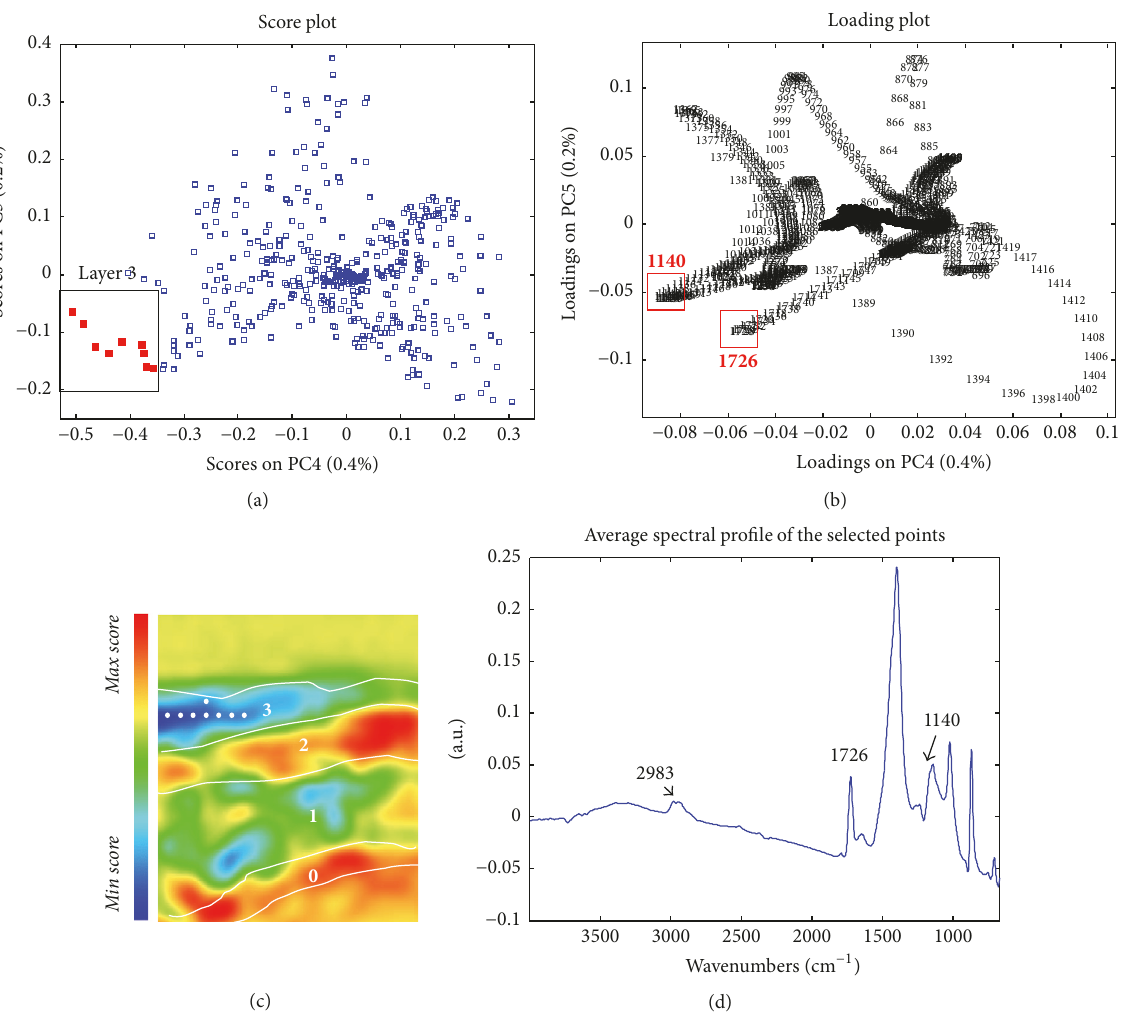
Figure 8: Sample PO1—(a) PC45 score plot: cluster highlighted in red indicates the objects localised within the PC4 score map (layer 3); (b) PC45 loading plot; (c) PC4 score map; (d) average spectral profile extracted from layer 3.